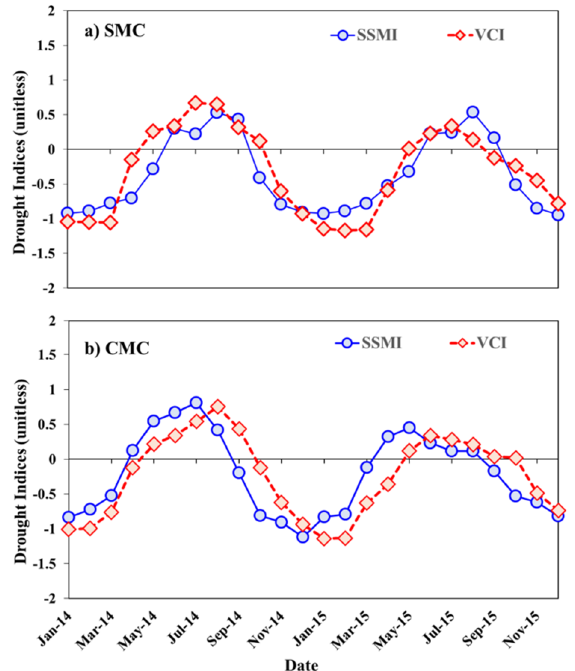
Figure 7. Temporal variations of SSMI and VCI during drought periods at ( a ) SMC and ( b ) CMC site.